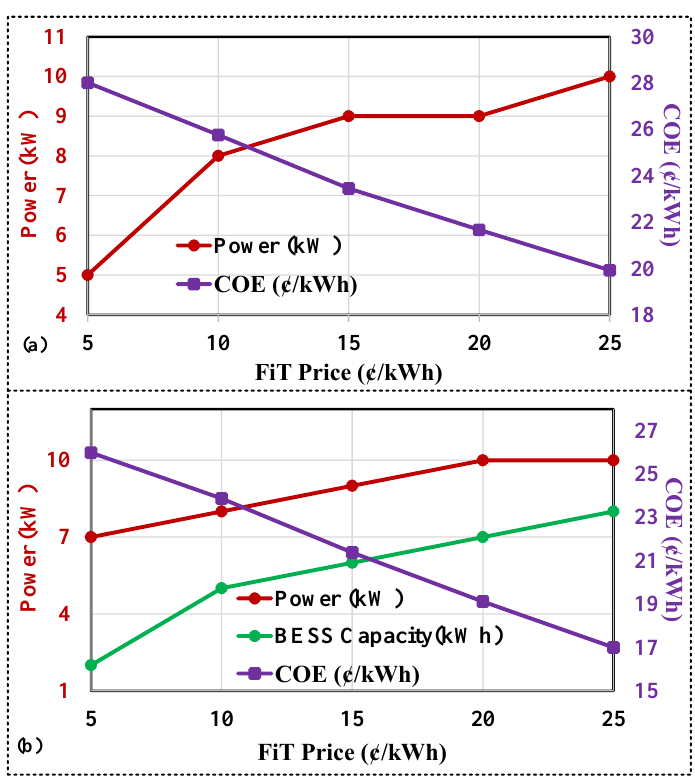
Figure 11. Sensitivity analysis for the impact of FiT price using option 2: ( a ) PV only; ( b ) PV–BESS.